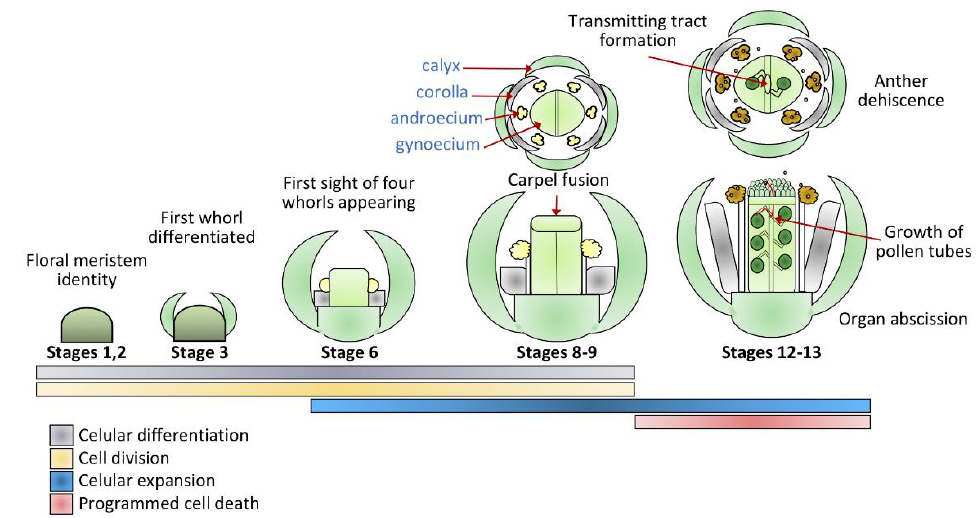
Figure 1. Flower development is related to cellular processes where the cell wall actively participates. In the earliest stages of flower development, cell proliferation is highly active. Up to Stage 3 of floral development, it can be seen how the calyx is already shown in the shape of a primordium, differentiated from the central structure that will give rise to the other three flower whorls. Cell proliferation and differentiation processes are essential in these steps, where the cell wall is actively involved. In Stage 6, the structures of the already differentiated floral whorls are conspicuously observed, where the sepals already cover the innermost structures. Later in Stage 8, the marginal meristem of the carpel is a structure that is already present and will give rise to tissues such as the placenta and ovules. For Stage 9, a shaped septum can be perfectly recognized. At Stage 12, the style and transmitting tract are differentiated as well as the valves, and the margins of the valves begin to be morphologically distinct. The petals and the stamens are structures where the cellular expansion is determinant for the growth of the organs. In Stage 13, the gynoecium is fully developed, with anthesis and self-pollination of the flower taking place. Programmed cell death is detected in the abscission zones where the organs open first by the separation of the cells.